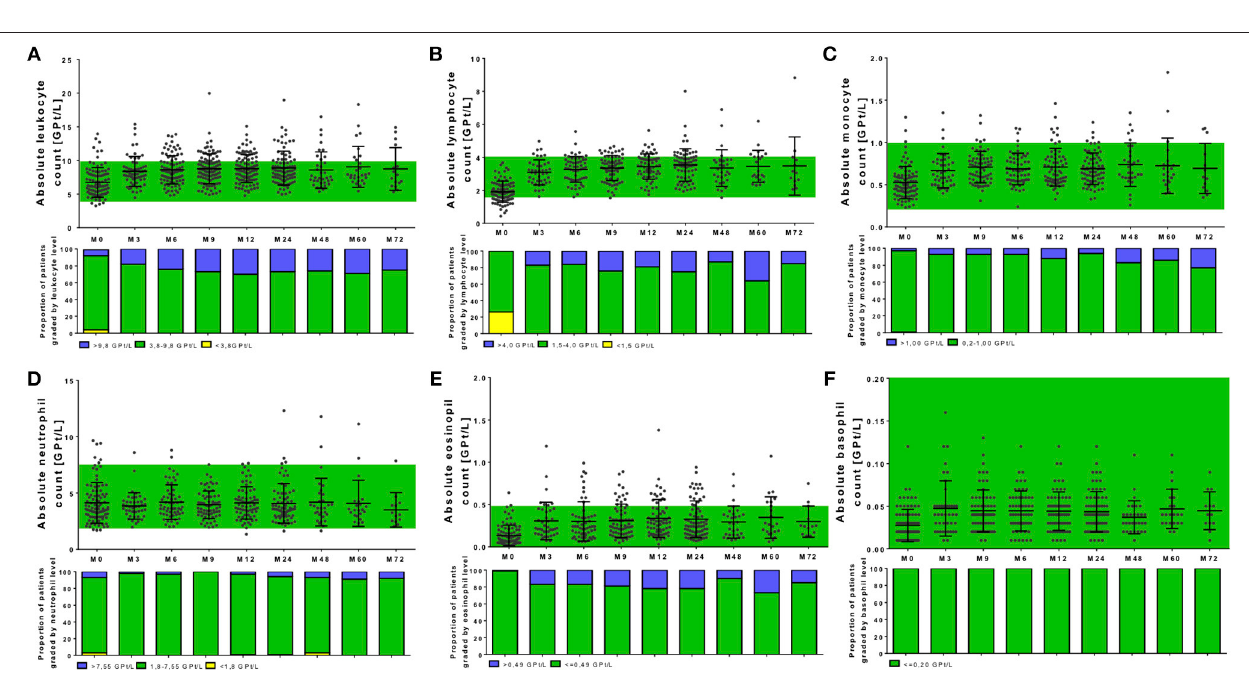
FIGURE 3 | Complete blood analysis during NAT treatment. Blood samples were taken before NAT started (M0) and every 3 months. Blood samples were analyzed in a certified medical laboratory. Analysis of complete blood count as leukocytes (A) , lymphocytes (B) , monocytes (C) , neutrophils (D) , eosinophils (E), and basophils (F) were included. Data are shown for baseline analysis (M0), month 3 (M3), month 6 (M6), month 12 (M12), and every 12 months follow up (M24, M48, M60, M72). Results are depicted as mean ± standard deviation. Green background indicates reference range of depicted parameters. Additionally, proportion of patients graded by white blood cell levels are shown: lower than reference range (yellow), reference range (green), and higher than the reference range (blue). Levels of significance are presented in Table 2 .